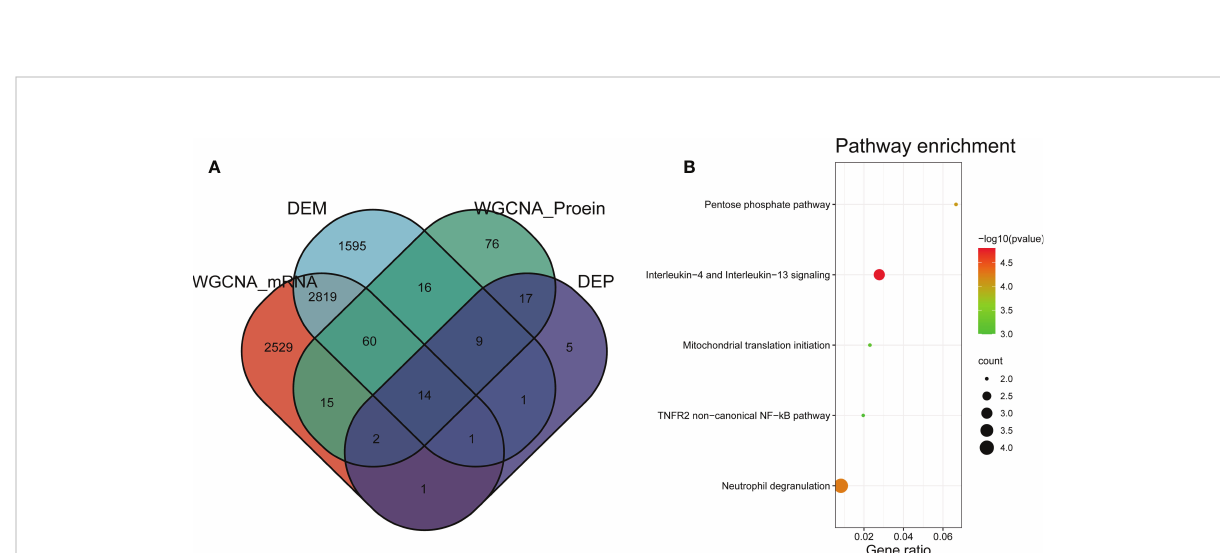
FIGURE 6 Identi fi cation of common genes between transcriptome and proteome in DMD. (A) Venn diagram of common genes shared by transcriptome and proteome. (B) Pathway enrichment analyses of the overlapping